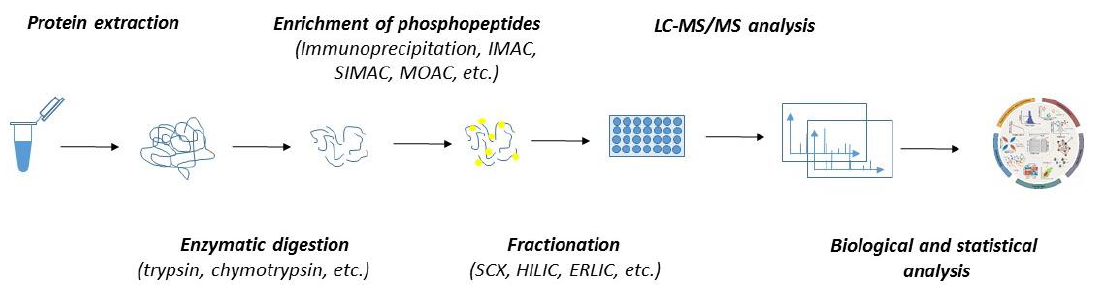
Figure 2. The workflow of MS-based quantitative phosphoproteomics. Both label-free and labelled samples might be subjected to protein extraction and enzymatic digestion by multiple proteases. The peptides can either be subjected to fractionation prior to the enrichment of phosphopeptides or directly subjected to phosphopeptide enrichment and fractionation applied after the phosphopeptide enrichment. Phosphopeptides are analyzed by LC-MS / MS. Mass spectrometry datasets are processed with software to generate the identification list and assign and quantitate the phosphorylation sites.